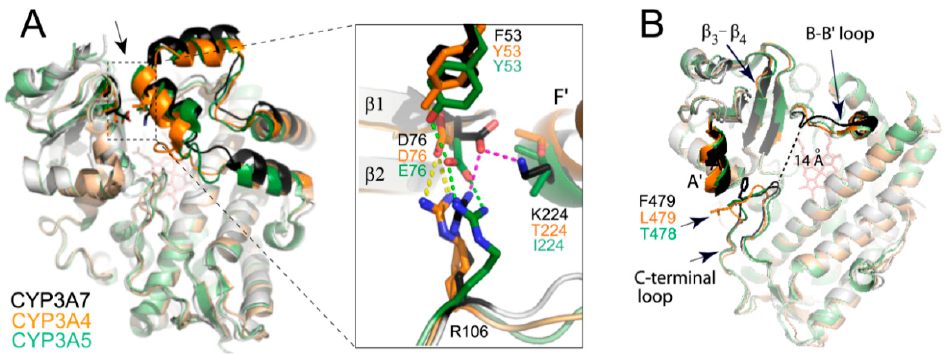
Figure 7. ( A ) Side views of CYP3A4 (5vcc) and CYP3A7 (molecule A) show relative positioning of the E- and H-helices. ( B ) Contact site between the F-, G-, E-, and H-helices. In CYP3A4, two hydrogen bonds are formed between the main chain atoms of the T187/F271 and A188/L272 pairs (depicted as red dotted lines), which together with the R260-D270 salt bridge could mediate communication between the helices. In CYP3A7, the E-helix shift leads to H-bond disruption/elongation and decreases the E/H-helix contact area by half.